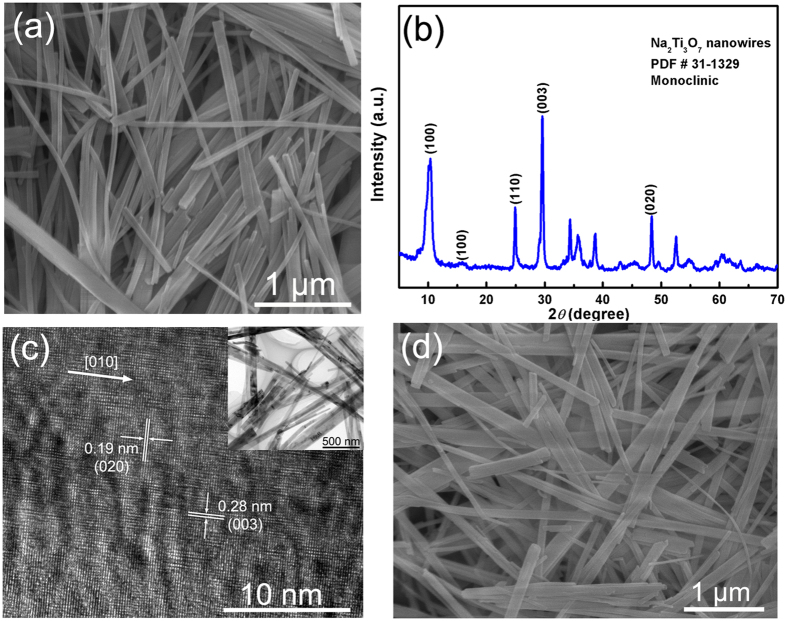
(a) SEM image, (b) XRD pattern and (c) TEM images of hydrothermally synthesized Na2Ti3O7 nanofibers (NT NFs). (d) SEM image of H2Ti3O7 NFs.